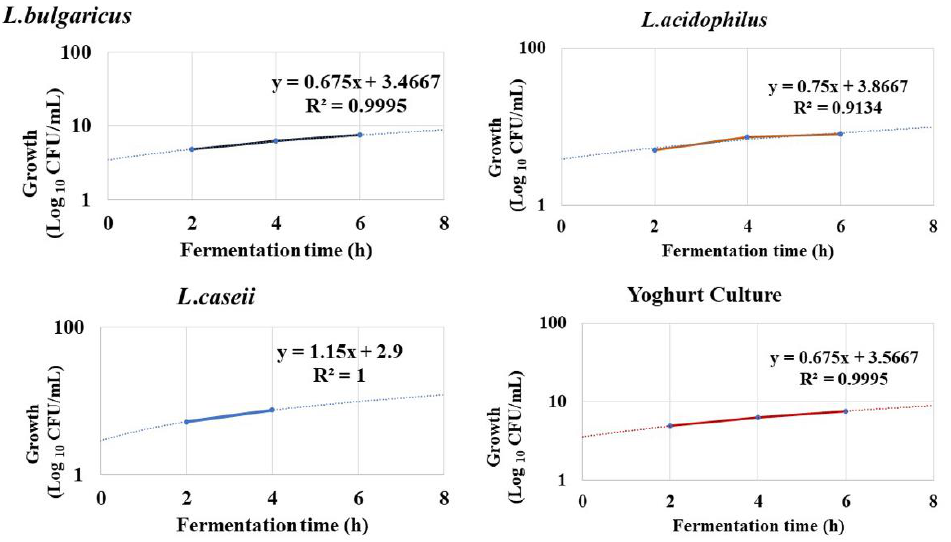
Figure 2. Growth rates of the three LAB strains against commercially yogurt culture (control) through the logarithmic growth phase during eight hours of fermentation indicating the correlation coefficient R 2 .